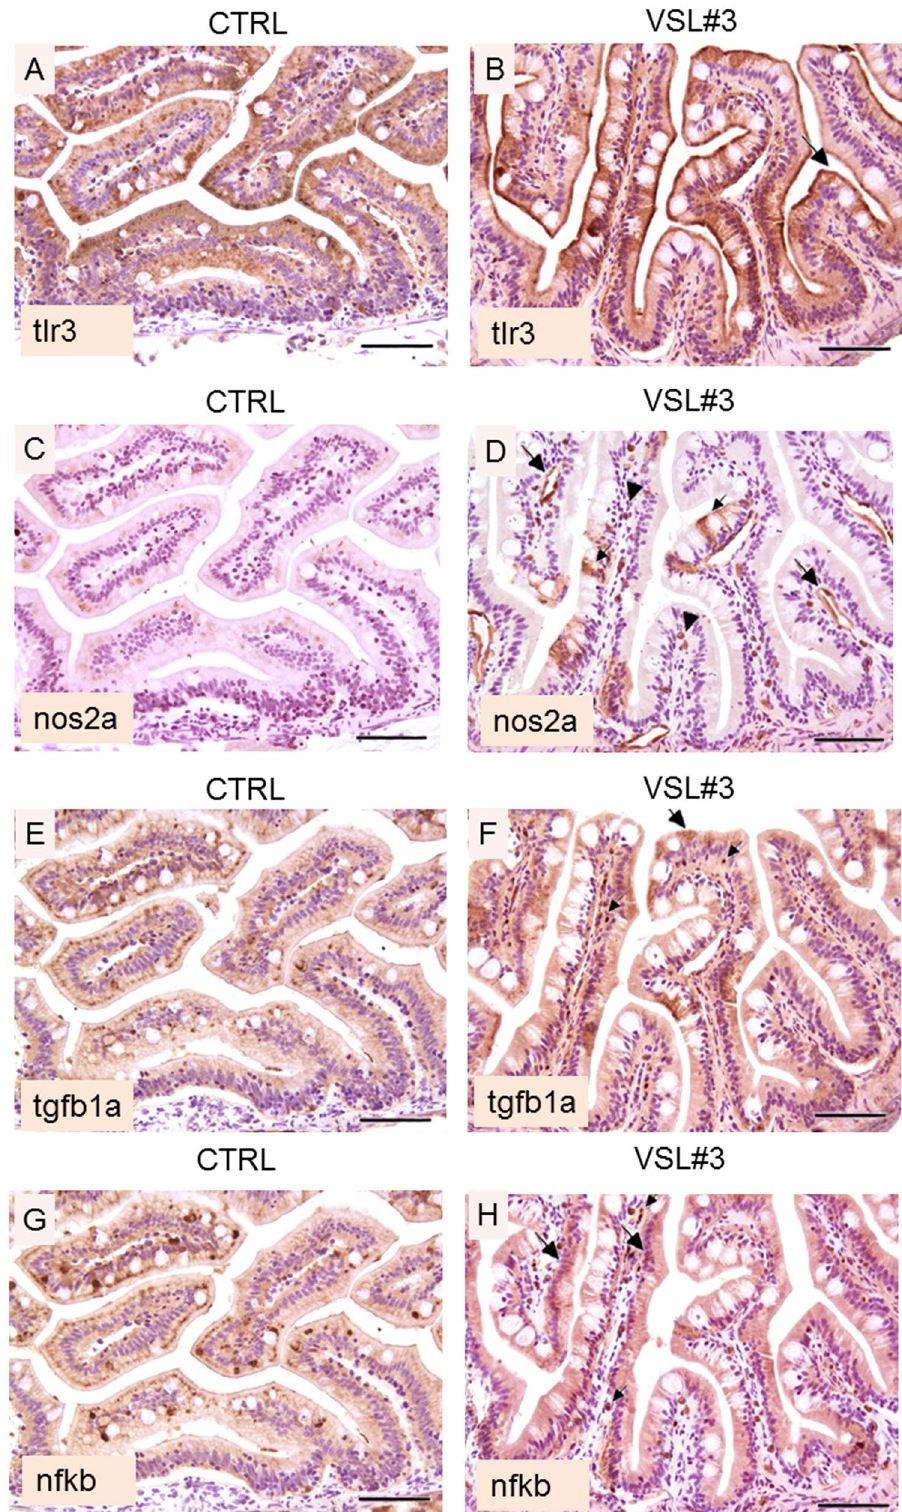
Figure 4. ( A ) Intestine section from untreated fish; note the evident reduction in intensity of tlr3 staining with respect to VSL#3-treated fish, characterized by a weak and irregular enterocyte expression, without any staining of cell free pole membranes (bar = 200 µ m). ( B ) Intestine section from treated fish; note the intense and diffuse presence of tlr3 in the mucosal epithelium. The stain is almost exclusively restricted along the superficial margin of enterocytes (arrow heads), and shows a continuous and constant pattern (bar = 200 µ m). ( C ) In section from untreated fish, note the substantial negativity for the presence of Nos2a, both in the epithelium and in endothelial cells (bar = 200 µ m). ( D ) In intestine section from treated fish, an